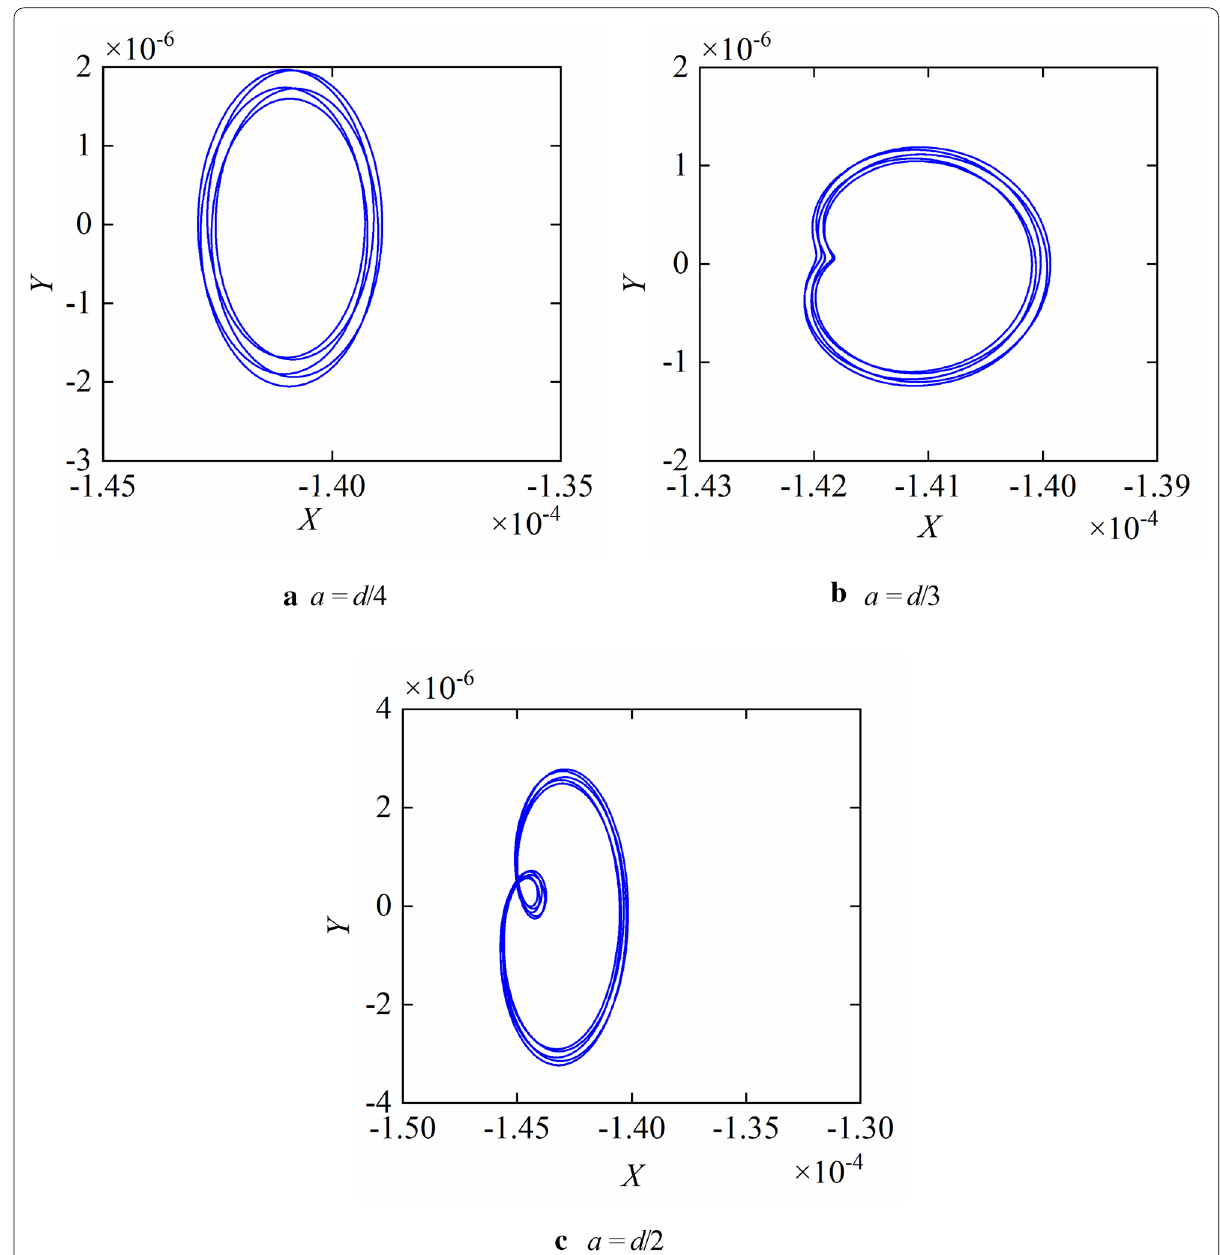
Figure 9 Shaft orbit of rotor system with a slant crack based fractional damping (under the different crack depth)